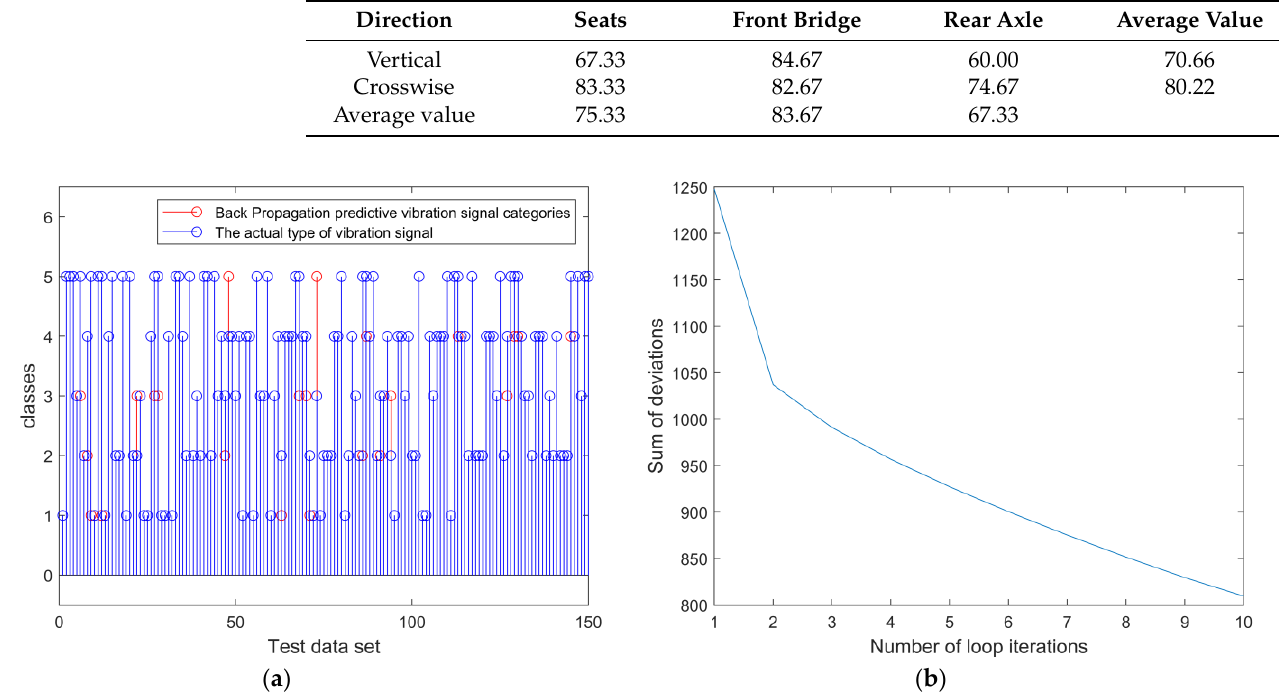
Figure 15. ( a ) Identification results of longitudinal vibration signal of front axle; ( b ) deviation sum of iteration training data.